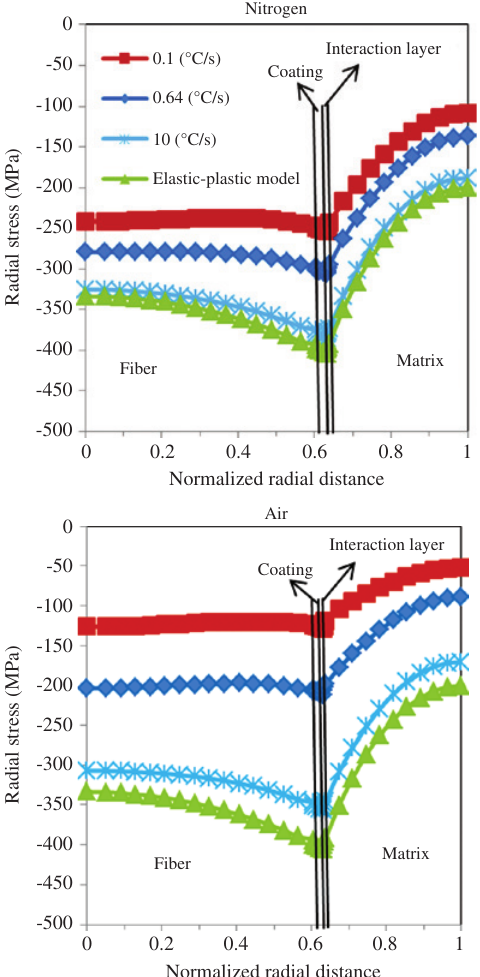
Figure 7: Radial residual stress distributions along the fiber/ coating interface in air and nitrogen environments for various cooling